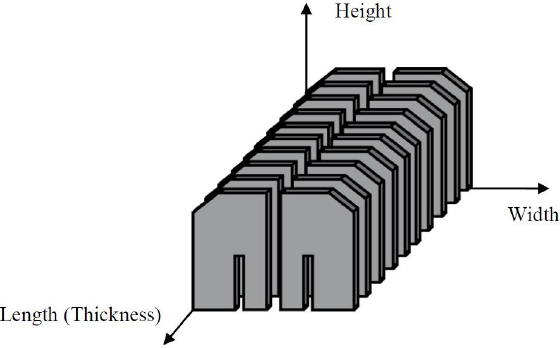
Figure 2. Slicing scheme of the investigated anode (approximately 0.6 × 0.6 × 1.5 m 3 ).